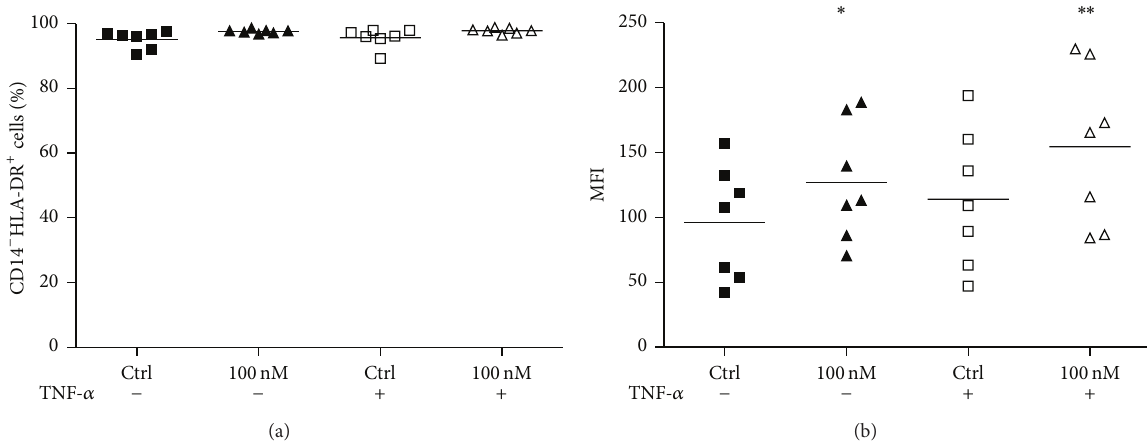
Figure 4: HLA-DR expression on dendritic cells during activation. After the differentiation period (5 days), cells were incubated for further 48 h with or without TNF- 𝛼 (50ng/mL), in the presence or absence of 100nM Oua. HLA-DR expression was analyzed by flow cytometry. Data are expressed as (a) the percentage of HLA + cells, or (b) MFI (mean of fluorescence intensity), and lines denote the means of seven independent experiments. ∗ and ∗∗ are significantly different from the control ( ∗ 𝑃 < 0.05 ; ∗∗ 𝑃 < 0.01 ).